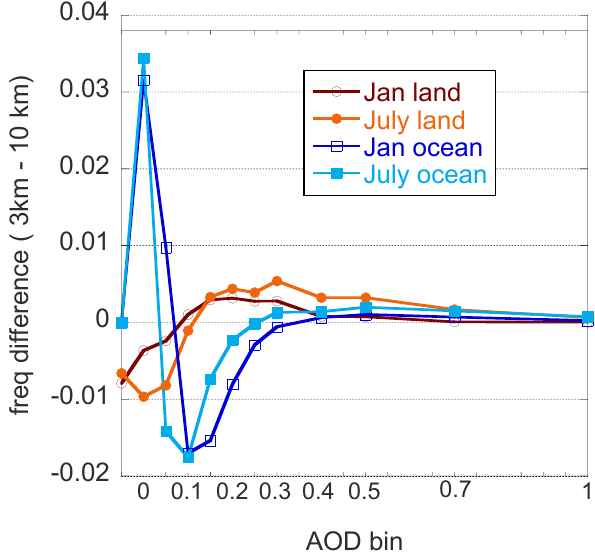
Fig. 10. Bin by bin differences between the frequency histograms of Fig. 9